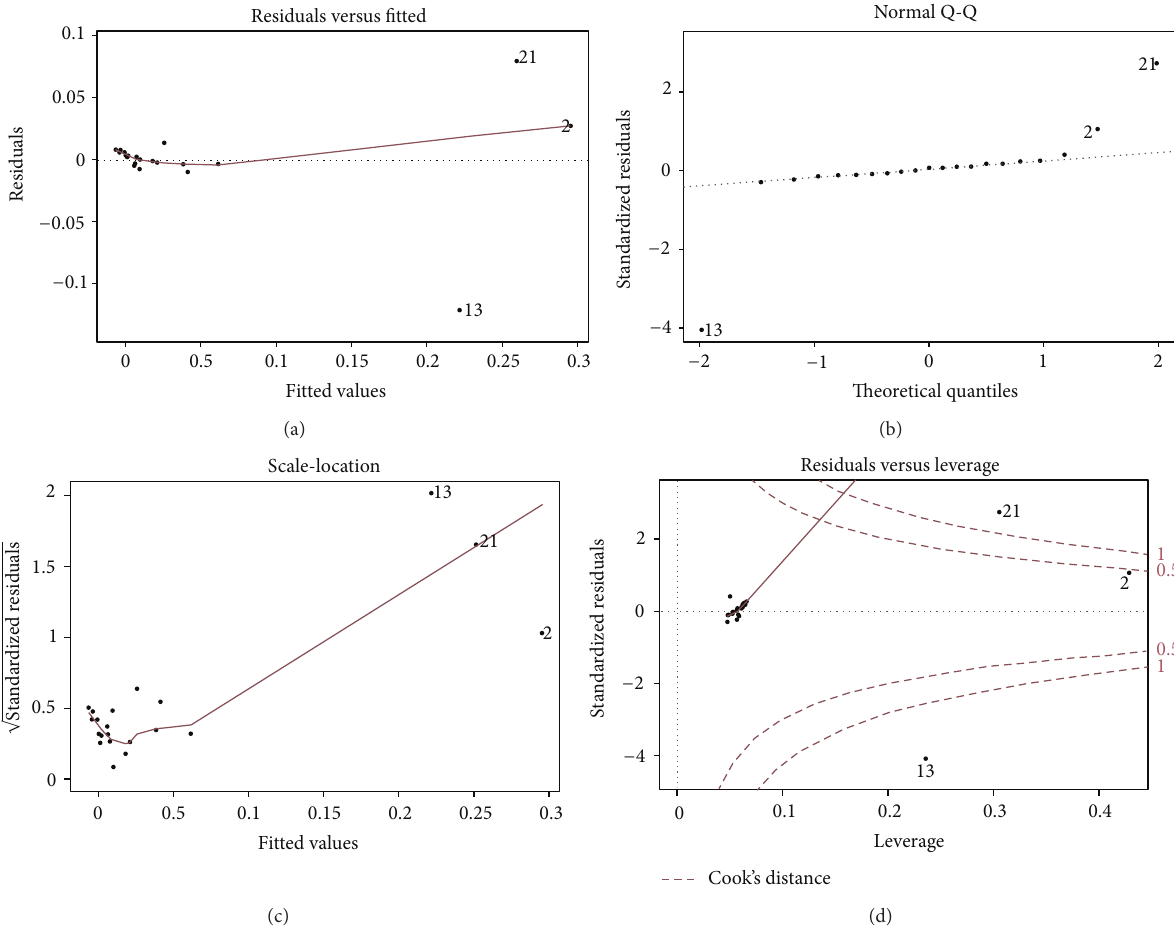
Figure 6: Assessment of regression analysis with residuals between relative peak areas of Syzygium aromaticum (SA) and Syzygium aromaticum combinedwith Curcumaaromatica